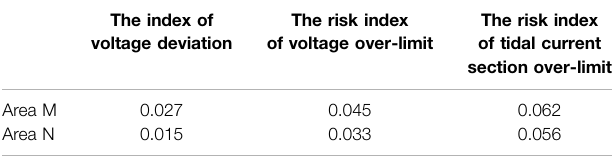
The index of voltage deviation